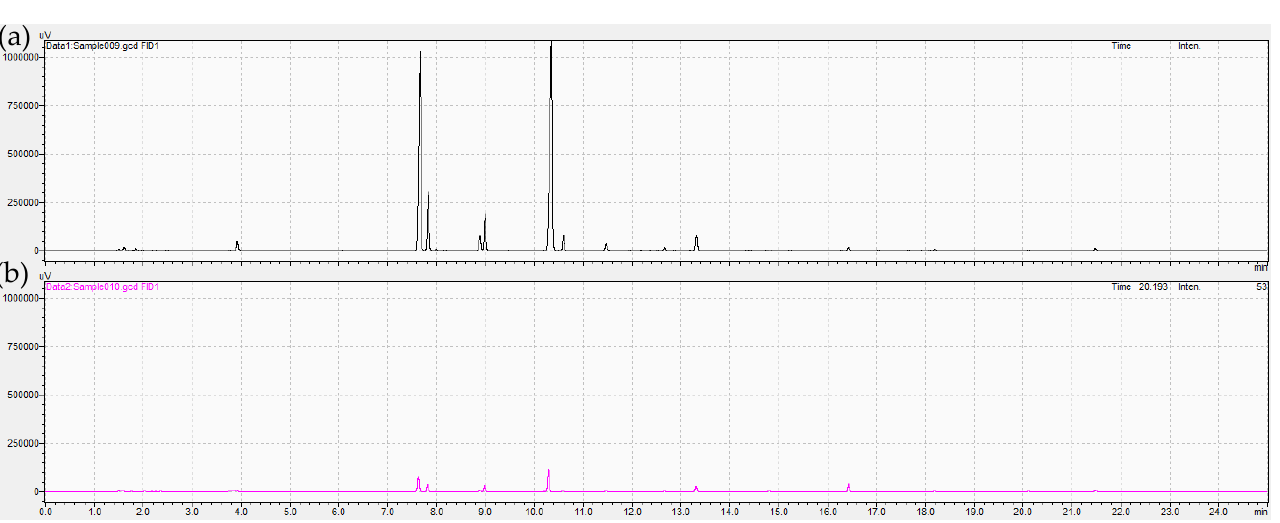
Figure 1. The GC chromatograms of ( a ) the extracted oil obtained from a screw press machine (Oil SM ) and ( b ) the milled raw seed (Oil RS ). The y-axis is normalized to the similar maximum intensity of 10.25 × 10 4 µV.